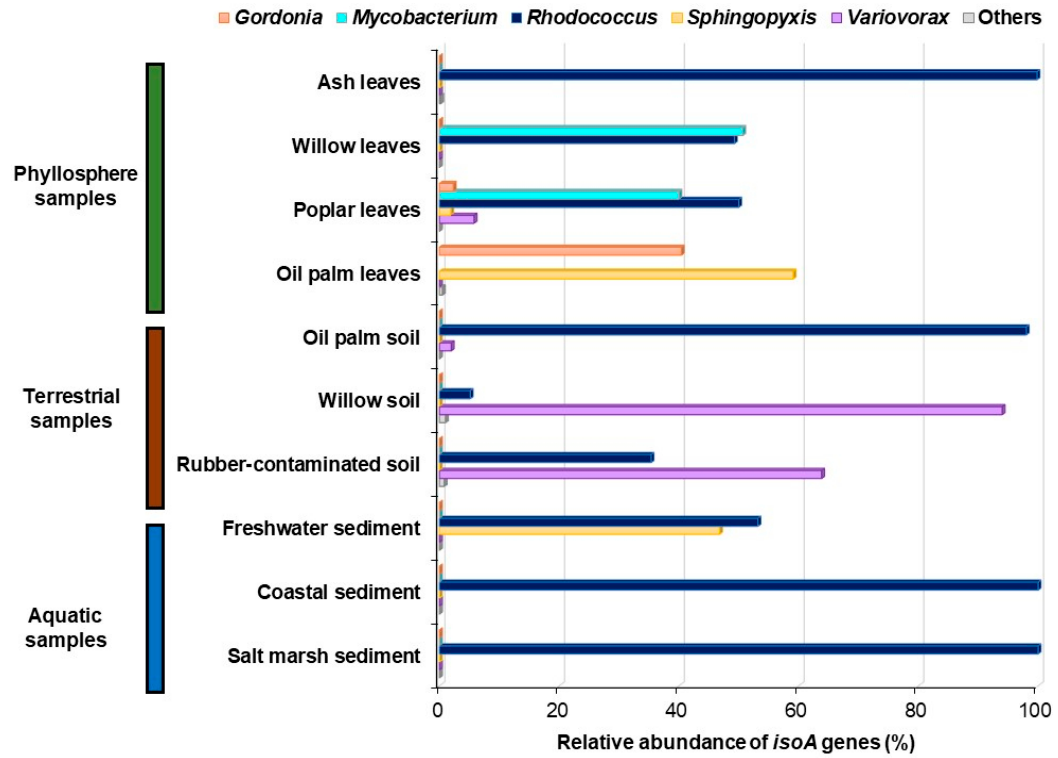
Figure 3. Relative abundance and diversity of isoA genes in environmental samples enriched with isoprene analysed by amplicon sequencing. Amplicon sequence variants (ASVs) closely related to IsoA from Gordonia are shown in orange; ASVs with the highest homology to IsoA from Mycobacterium are represented in light blue; ASVs encoding proteins homologous to Rhodococcus IsoA are shown in dark blue; ASVs with the highest homology to Sphingopyxis IsoA are coloured in yellow; ASVs closely related to IsoA from Variovorax are represented in purple. Data from [69].